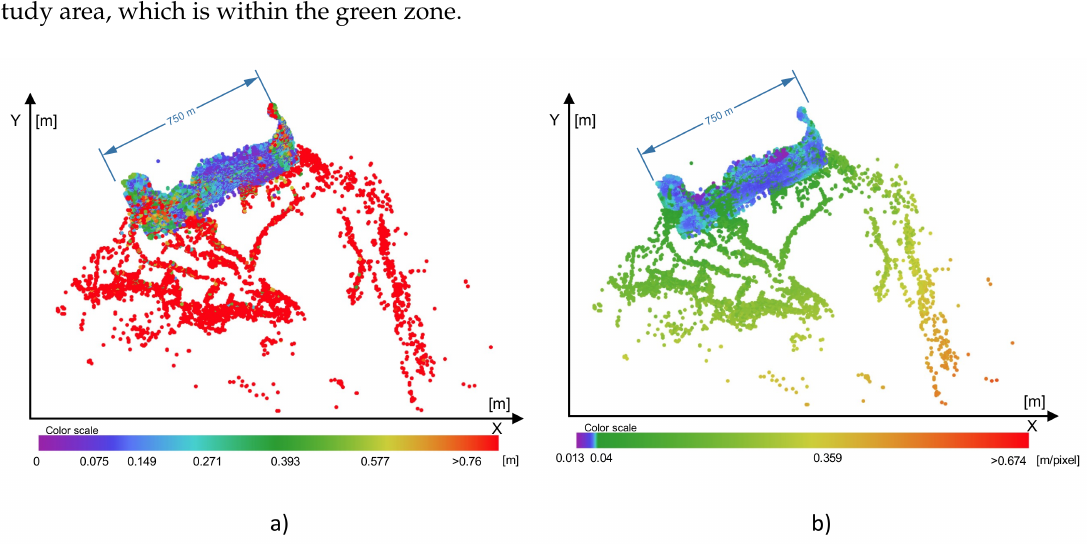
Figure 6. ( a ) Tie-point position uncertainties. ( b ) Resolution of individual tie-point